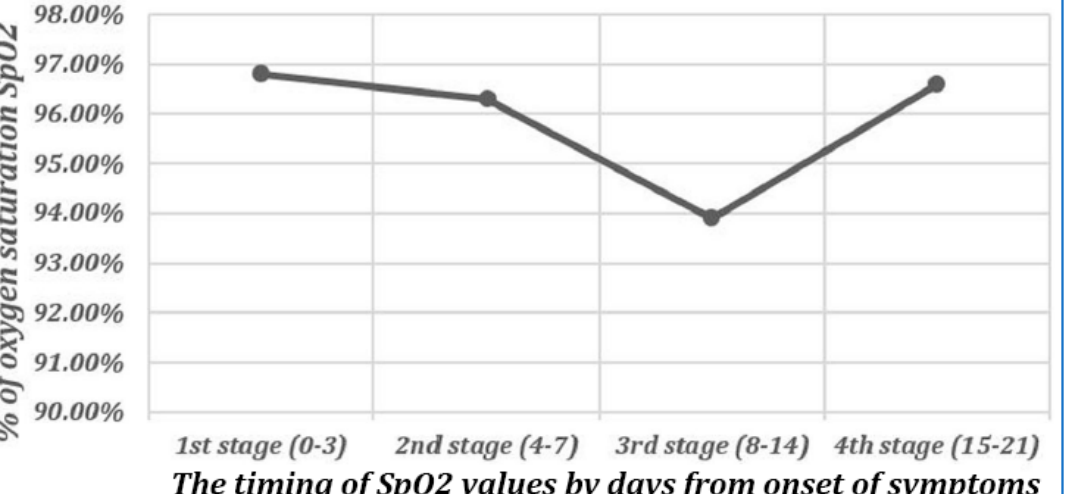
Figure 5. Changes in oxygen saturation during different stages of follow-up of cases with COVID-19 infection. Reproduced from Osman et al., 2020 [31] (CC-BY 4.0). These values were obtained from 125 PCR-confirmed COVID-19 inpatients, March-August 2020, with all values obtained on room air except for 3 patients in Stages 1 and 2, 13 in Stage 3, and 1 in Stage 4. As shown, the mean value of SPO2 decreases from Days 0–3 to Days 8–14; it is inversely correlated with the severity of pulmonary CT abnormalities in these patients throughout the full period of observation.